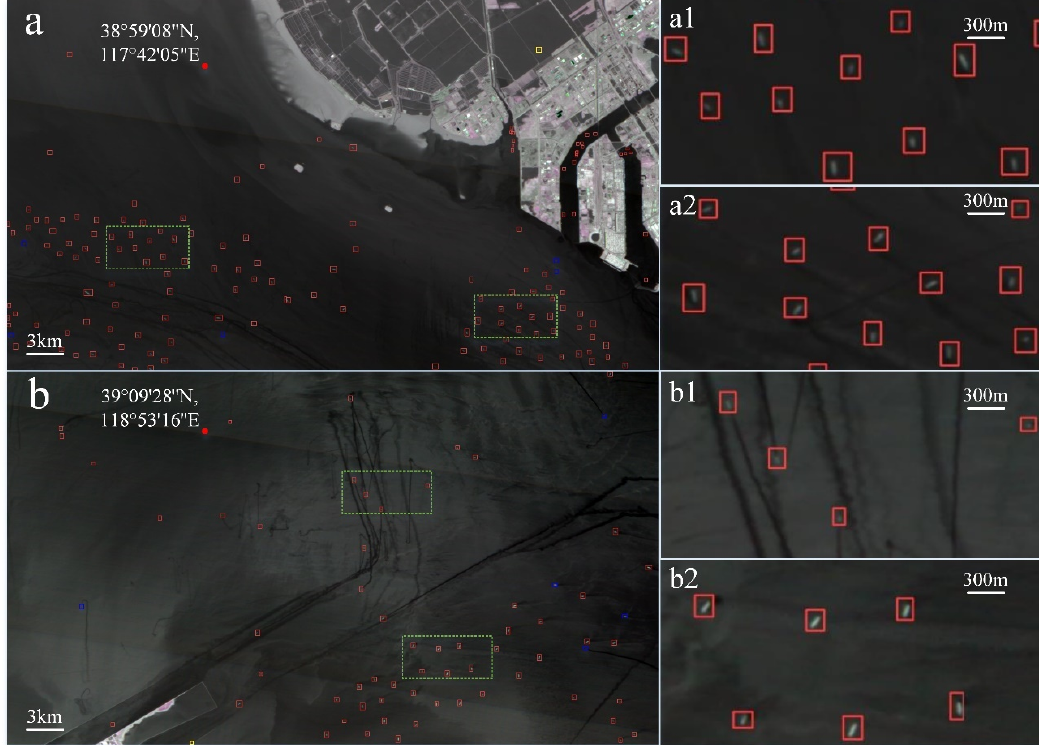
Figure 11. The results of daytime ship detection by using the TISD in ( a ) Tianjin Port and ( b ) Partial Sea of Bohai during daytime. (The red boxes show the correct vessel detected, the yellow box shows the false alarm, and the blue boxes show the missing alarms). Table 8. Ship detection results for different scenarios and times. Figure 10a. Shanghai Port about 21 o’clock at night Figure 10b. Sea near Pudong Airport Figure 11a. Tianjin Port